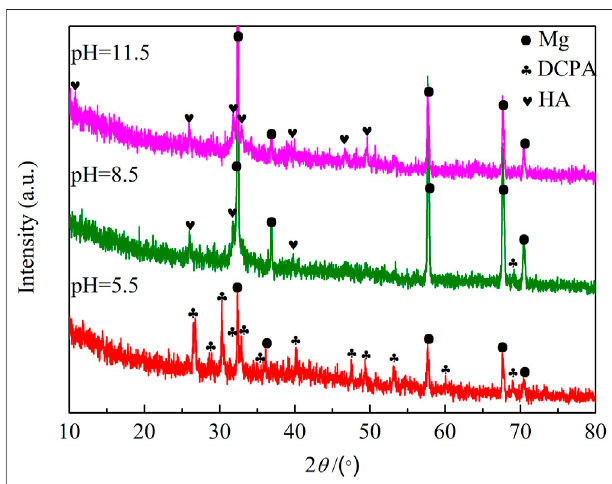
FIGURE 2 | XRD patterns of samples treated at different pH values.